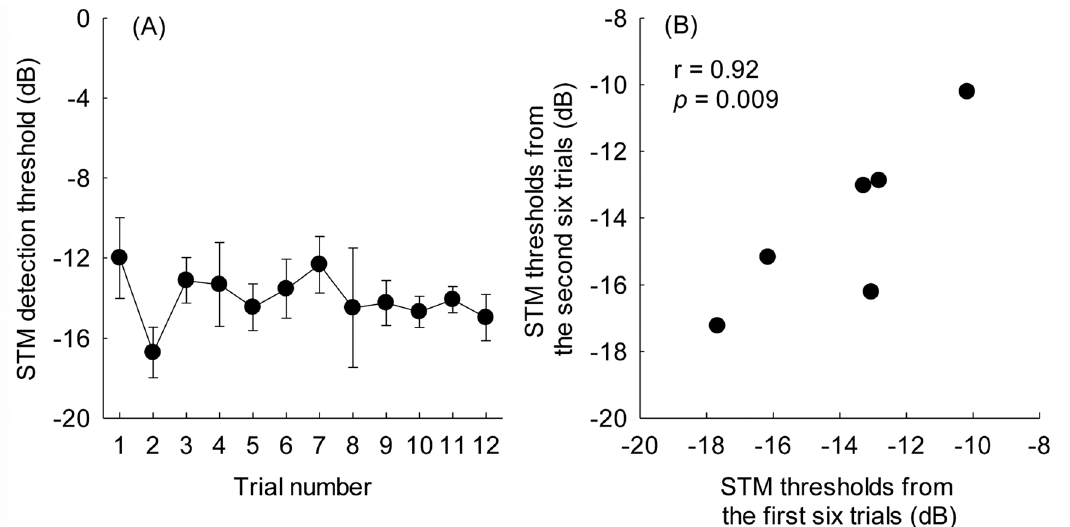
Fig 5. (A) Effects of learning for the STM detection test. The figure shows mean STM detection thresholds as a function of trial number for the 10 Hz and 0.5 c/o condition. Error bars show one standard error based on data from 6 CI subjects. (B) Reliability of the STM detection test. The relationship between